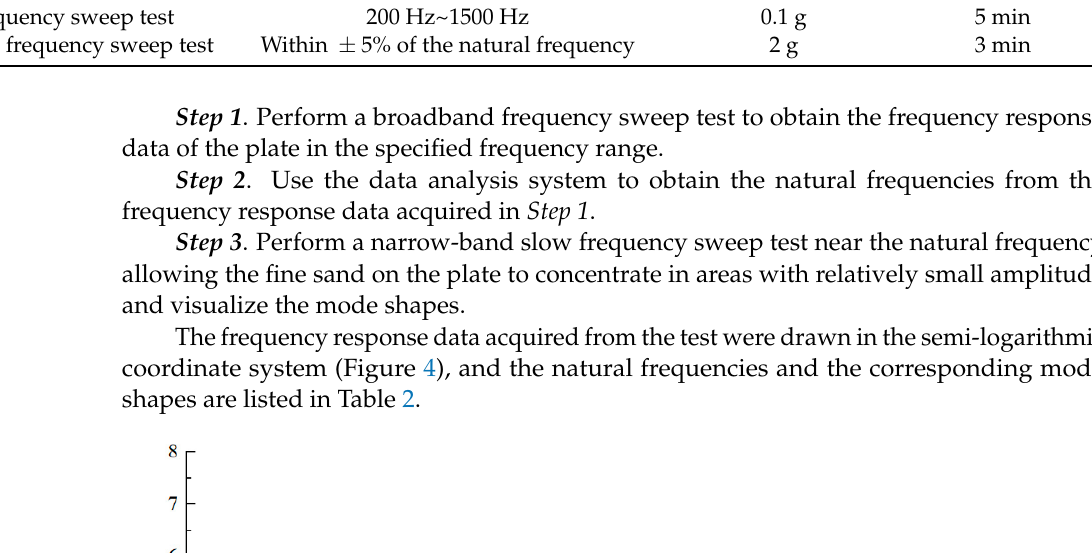
Table 1. Frequency sweep test conditions.